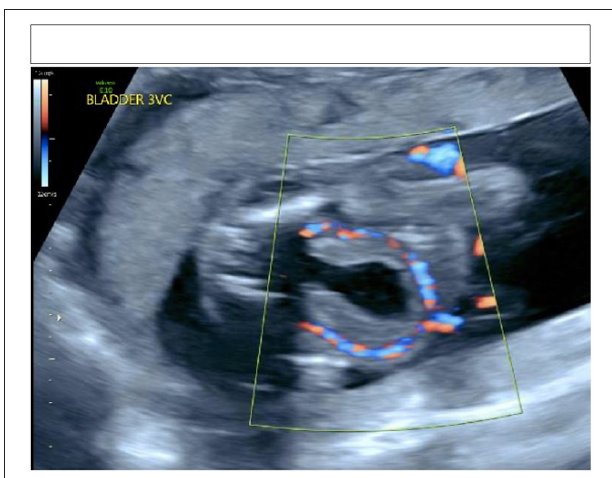
FIGURE 1 | Keyhole sign on prenatal ultrasonography.